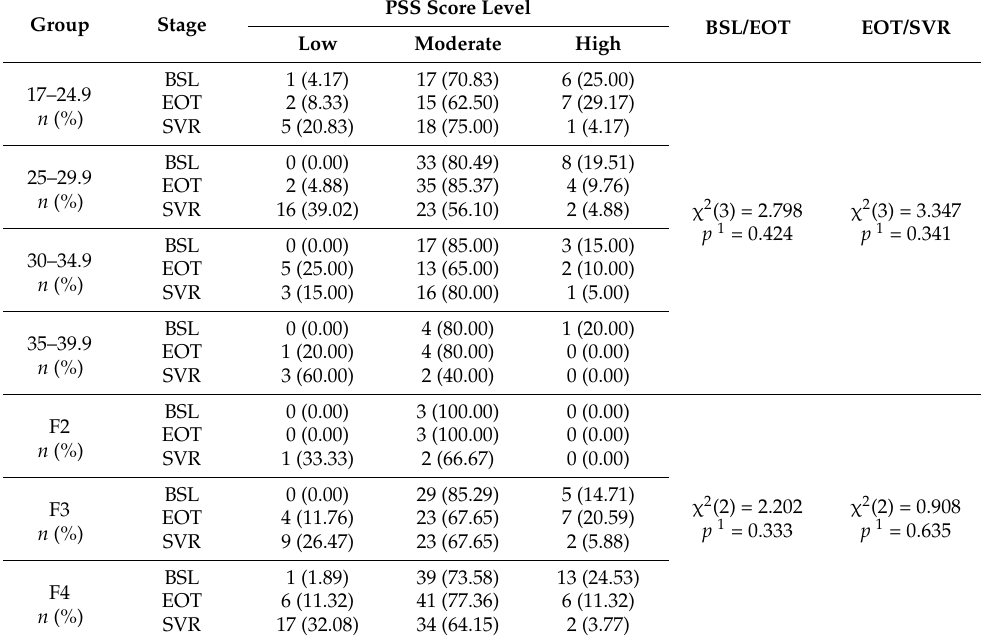
Table 4. The levels of perceived stress (PSS) correlated with the clinical characteristics of the study